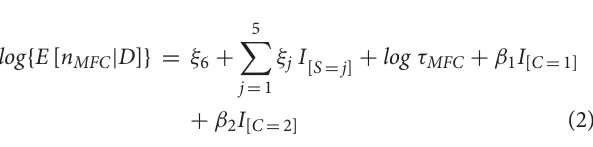
Table 6: Derivation of Model 1 (Without TRD Offset) and 2 (With TRD Offset) and Table 6 in Supplementary